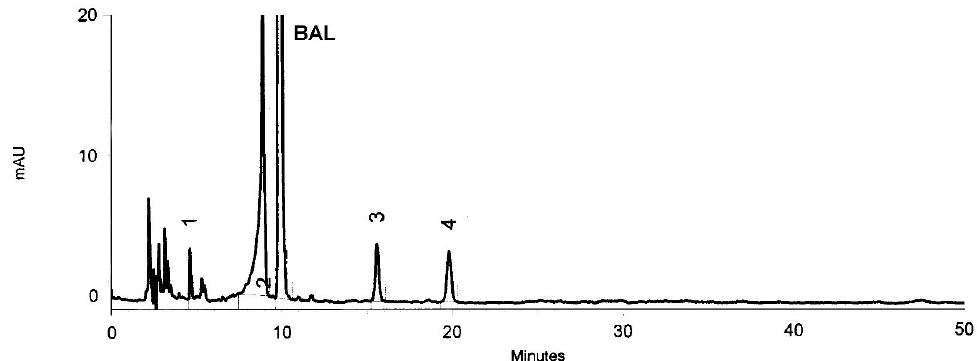
Figure 9. Chromatogram of BAL after oxidation by KMnO 4 in the acidic medium after incubation for 1 h at RT.